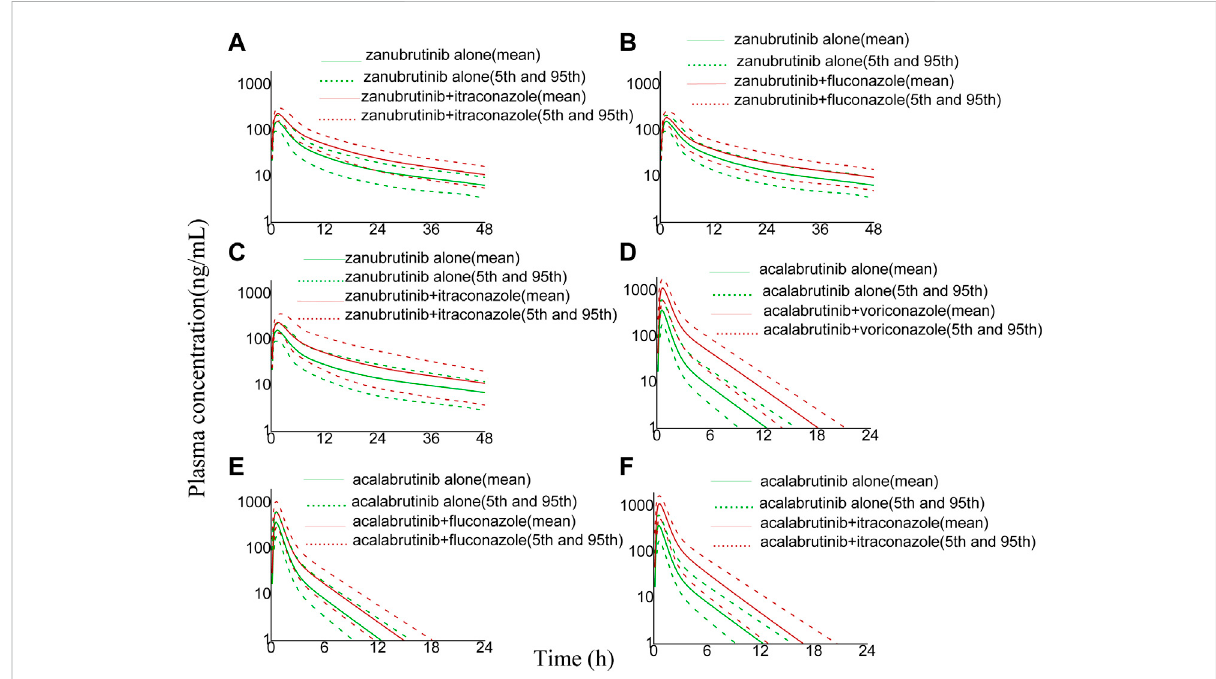
FIGURE 4 Simulatedplasma concentrations (logarithmic concentration axis) of a single-dose zanubrutinib (160 mg) dosed alone or concomitant with (A) voriconazole (200 mg), (B) fl uconazole (200 mg), (C) itraconazole (200 mg), and a single-dose acalabrutinib (100 mg) dosed alone or concomitant with (D) voriconazole (200 mg), (E) fl uconazole (200 mg), (F) itraconazole (200 mg).